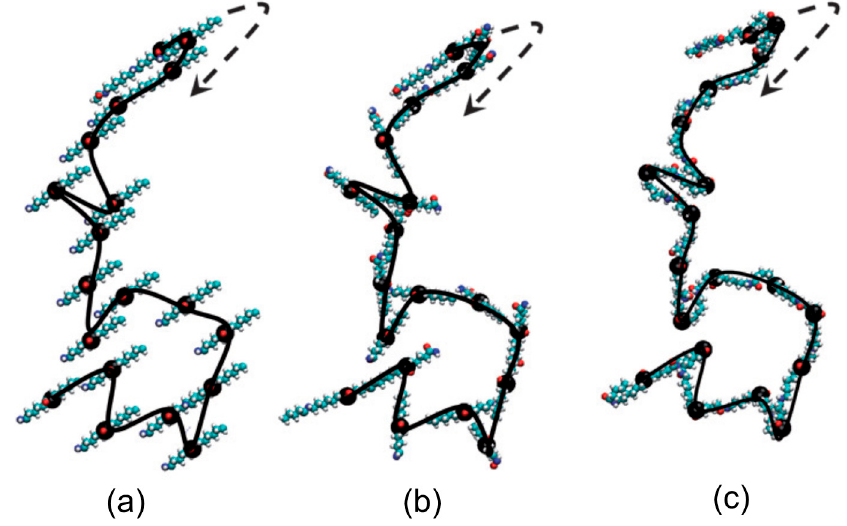
Figure 9. Reverse-mapping procedure for PA-66: ( a ) insertion of the atomistic segments (colored beads) on the underlying random walk chain (solid black line); ( b ) re-orientation of the atomistic segments; ( c ) final configuration of the reconstructed atomistic chain. The arrow indicates the grow direction of the chain. Reproduced from Carbone et al. [424] with permission of The Royal Society of Chemistry.